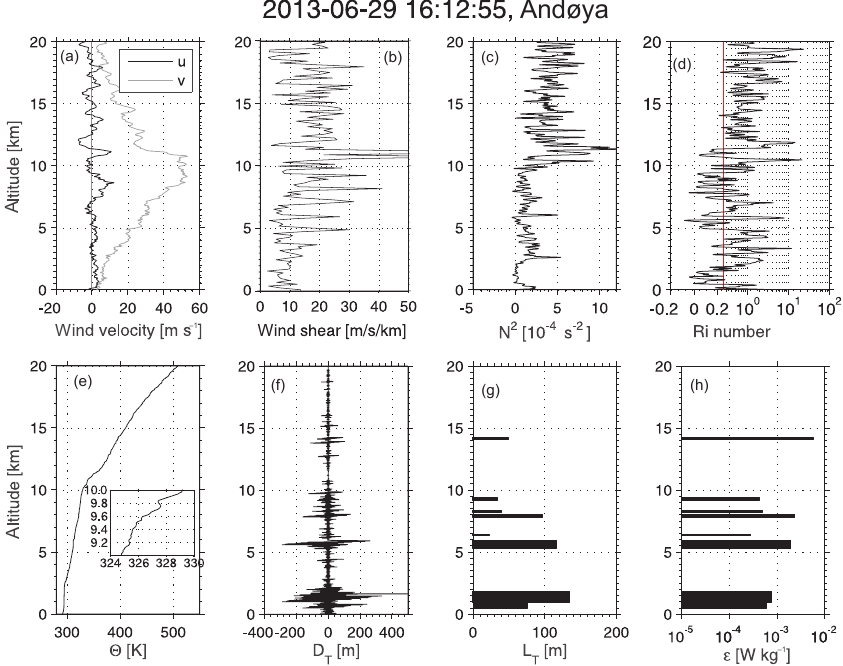
Figure 4. Vertical profiles of the atmospheric parameters inferred from the radiosonde on 29 June 2013 at Andøya: (a) velocity of zonal wind u (black) and meridional wind v (blue), (b) vertical shear of horizontal wind, (c) Brunt–Väisälä frequency squared ( N 2 ), (d) Richardson number calculated based on a height resolution of 150m and the red line indicating Ri = 1 / 4 (see text for details), (e) moist-conservative potential temperature (i.e. including the effects of air moisture), (f) Thorpe displacement ( D T ), (g) Thorpe length ( L T ), and (h) the derived energy dissipation rate ε based on Thorpe